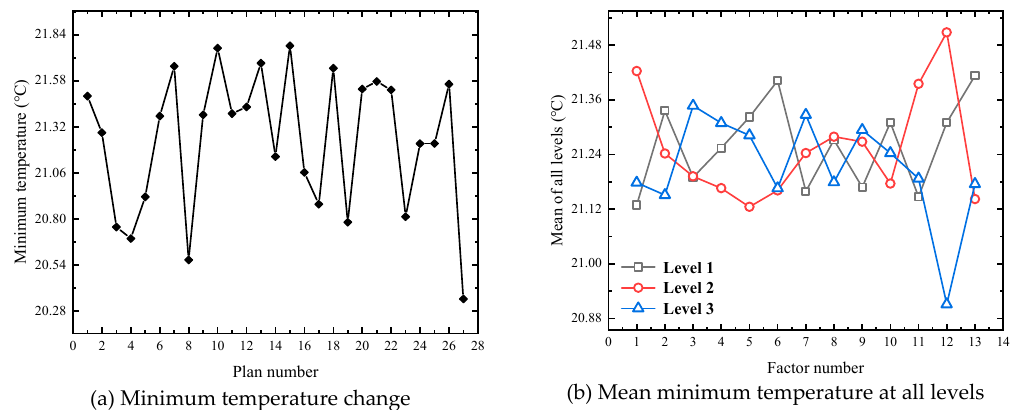
Figure 5. Variation of simulation results of minimum temperature in orthogonal experiment.